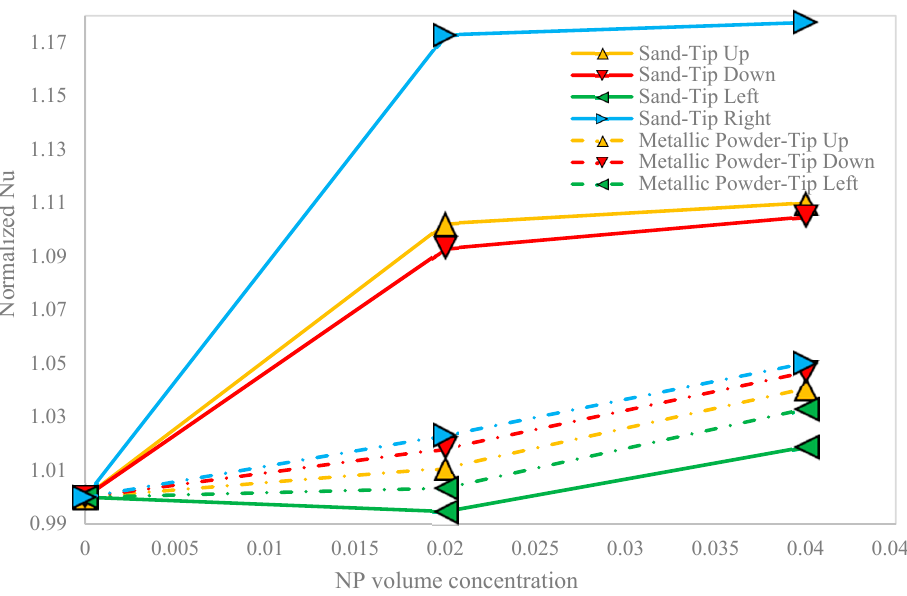
Figure 12. The variation of the normalized Nu of the NF versus the NP volume concentration, in all cases.